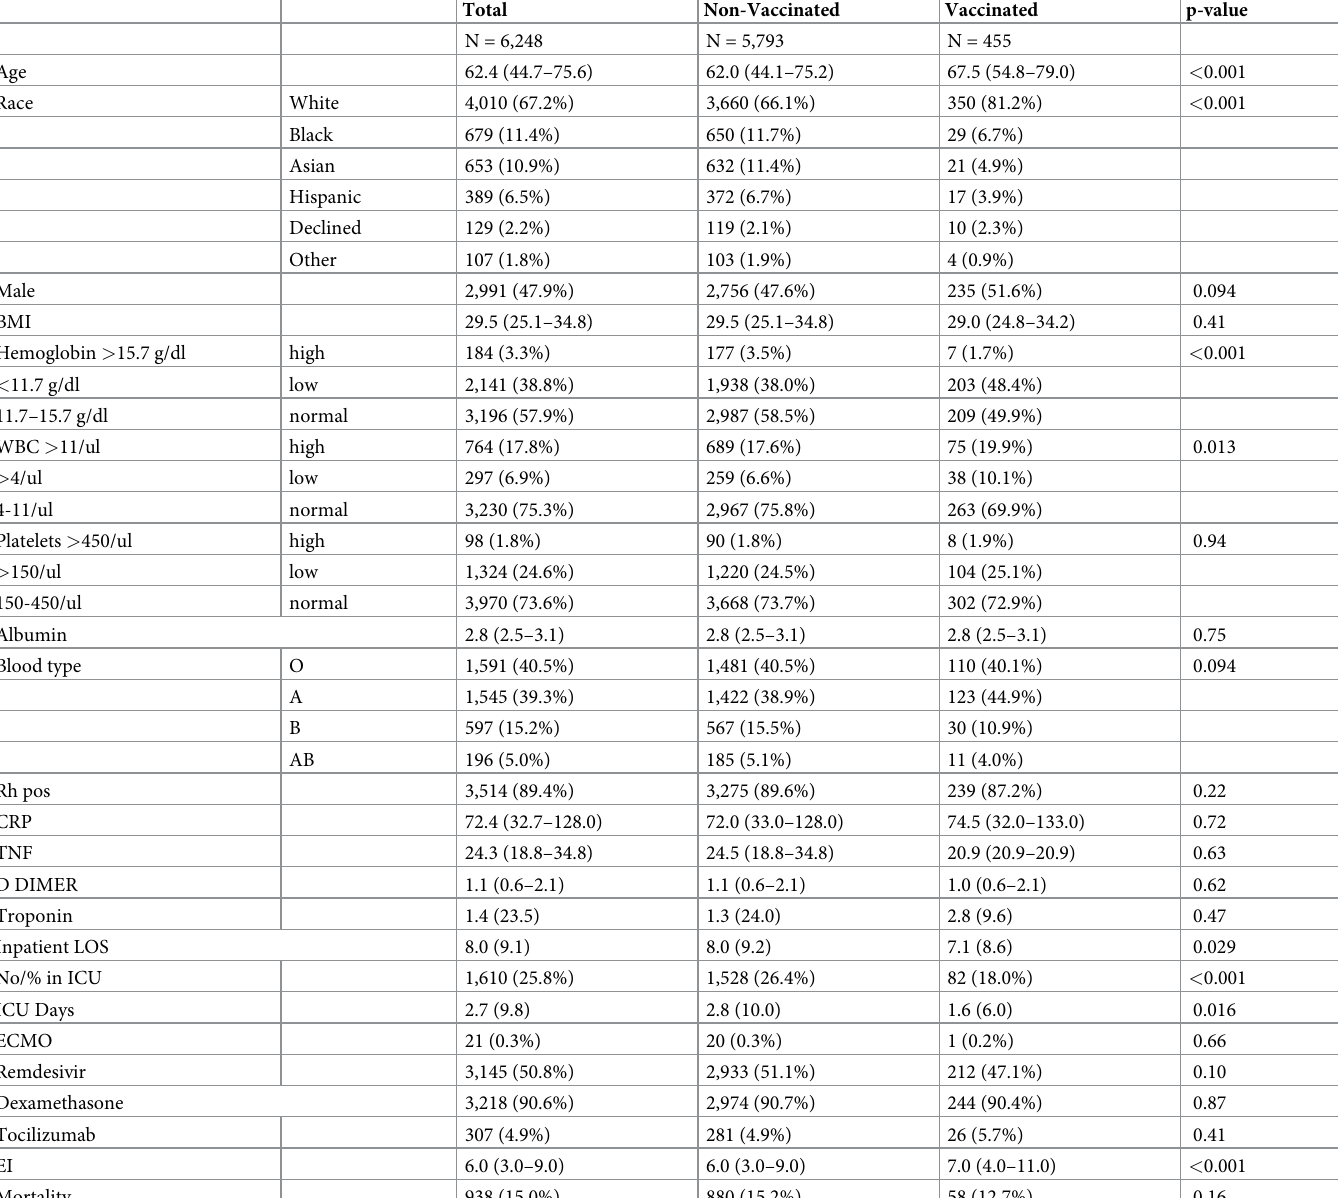
Table 3. Comparison of vaccinated and non-vaccinated SARS-CoV-2 patients admitted to hospital. Categorical variables expressed as count and percentage, and con- tinuous variables as median and